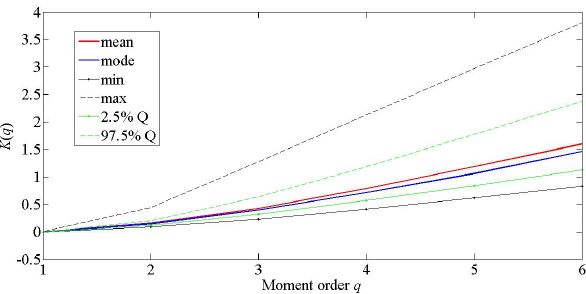
Fig. 9. Prediction intervals of the moment scaling function K(q) versus the order q for the log-normal series generated by the down- scaling model (Lombardo et al.,